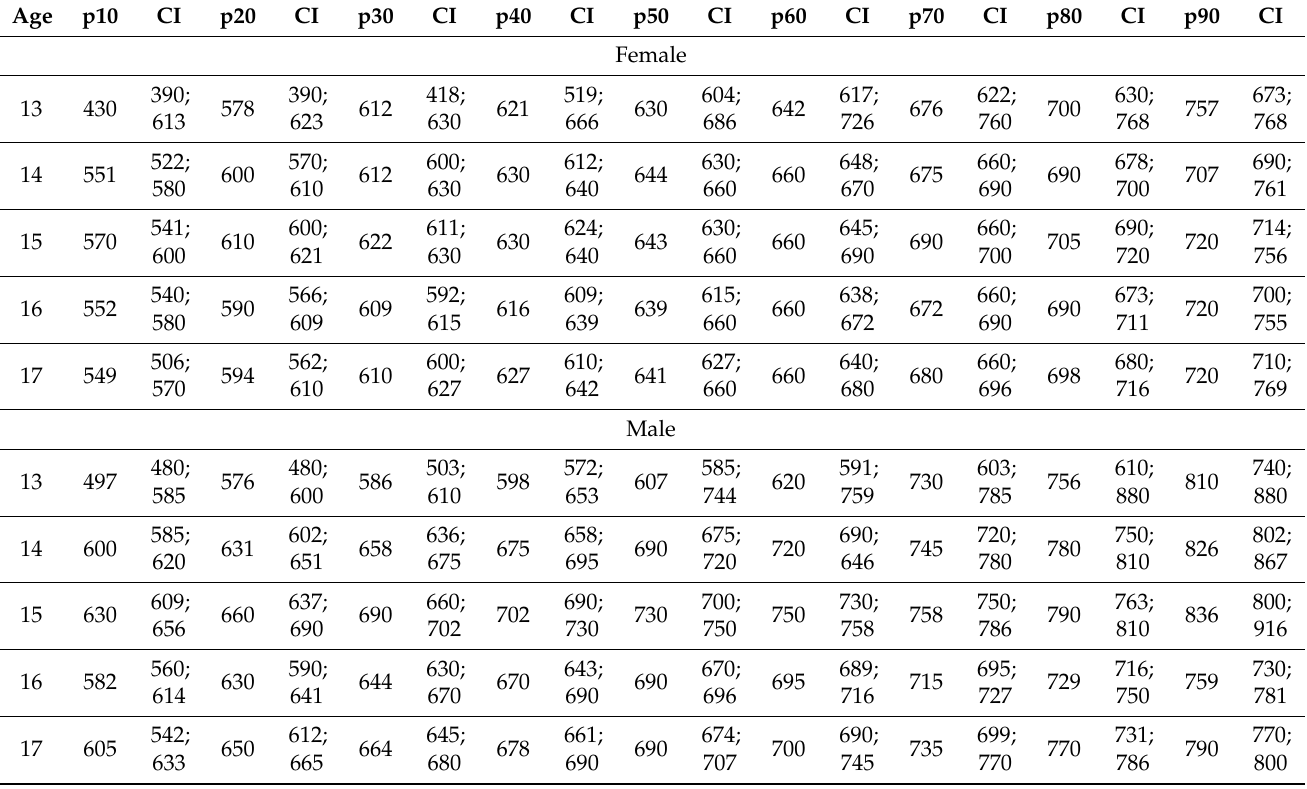
Table 3. Percentiles of distance traveled in the SMWT by female and male according to